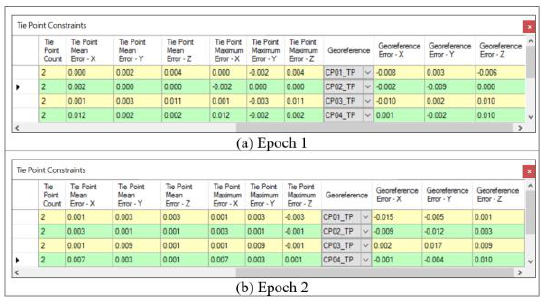
Table 5. The tie point constraint value of (a) Epoch 1 and (b) Epoch 2 for registration and georeferencing error computed